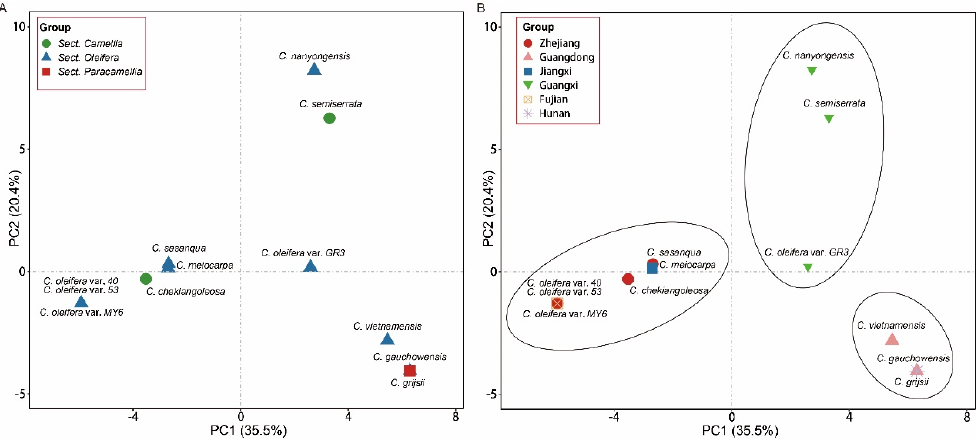
Figure 7. Principal component analysis plots of the 12 Camellia individuals. The meanings of each shape are indicated by the legend at the top.